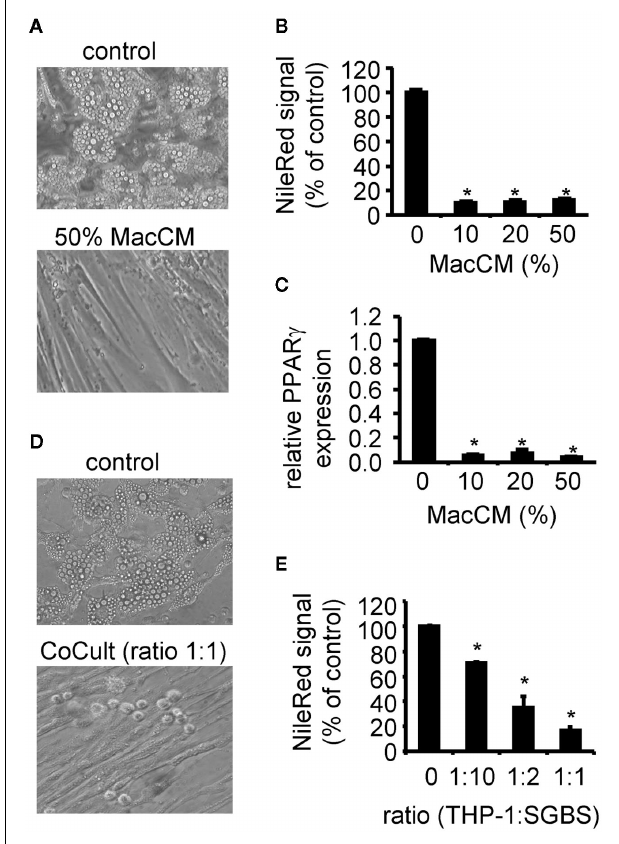
FIGURE 2 | Effect of macrophage-conditioned medium (MacCM) and co-culture on adipogenic differentiation. (A) SGBS preadipocytes were incubated with MacCM (10, 20, 50%) or vehicle during adipogenic differentiation. At day 10 cells were analyzed. (B) Lipid accumulation was assessed by staining the cells with the lipophilic dye Nile Red. (C) mRNA expression of PPAR γ was analyzed by qPCR and normalized to succinate dehydrogenase complex subunit A (SDHA) and related to control using the ΔΔ Ct method. (D) In vitro differentiatedTHP-1 macrophages were added to cultures of SGBS preadipocytes at increasing rates (THP-1:SGBS 1:10, 1:2, 1:1) during adipogenic differentiation. (E) Lipid accumulation was assessed by staining the cells with Nile Red. Nile Red signals of macrophage cultures were subtracted as background. Data are presented as mean + SEM of three independent experiments. * p <